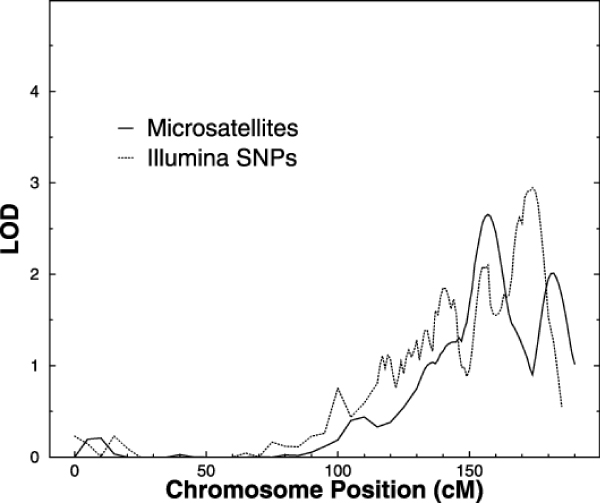
Trivariate multipoint linkage results for chromosome 7.